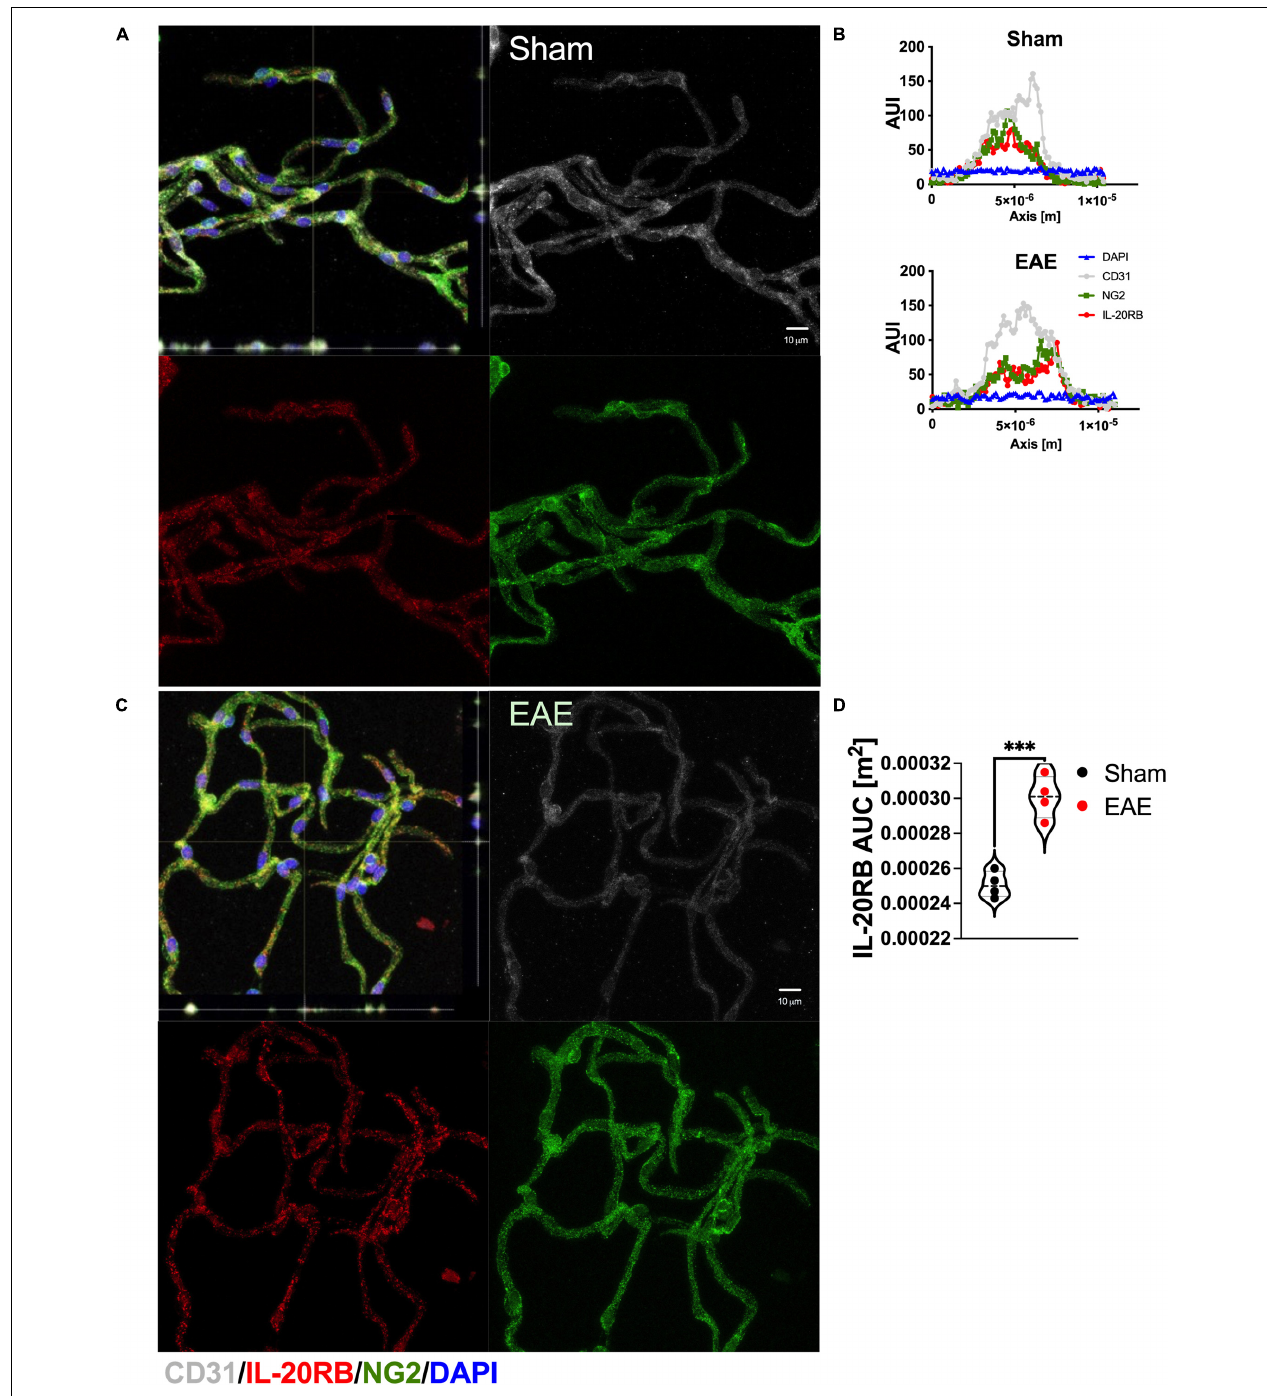
FIGURE 4 | Enhanced expression of IL-20RB in C57BL/6 mice in spinal microvessels at peak of EAE. Spinal cord microvessels were isolated from sham-immunized and actively immunized C57BL/6 mice at peak of EAE (peak, ∼ 14 dpi), n = 4. Microvessels were immunolabeled for CD31 (white, endothelial marker), IL-20RB (red), and NG2 (green, mural/pericyte marker), and nuclear stained with DAPI (blue); scale bar = 10 µ m (A,C) . IL-20RB colocalized with both CD31 and NG2, which suggests endothelial and mural cells expression of IL-20RB. Histogram analysis was performed to determine microvessels diameter to confirm low-caliber (not shown) and fluorescence arbitrary units of intensity (AUI) (representative AUI vs. axis plots, B ). Area-under-curve (AUC) was calculated for IL-20RB AUI for 25 microvessels per subject. Means AUC for spinal cord IL-20RB expression of sham-immunized mice vs. actively immunized mice (mean ± SD: 2.5 × 10 − 4 ± 7.4 × 10 − 6 vs. 3.0 × 10 − 4 ± 1.6 × 10 − 5 ) were analyzed by unpaired t -test showing extreme statistically significant difference, p < 0.0001 (D) . Results are shown as mean ± SD, *** p <